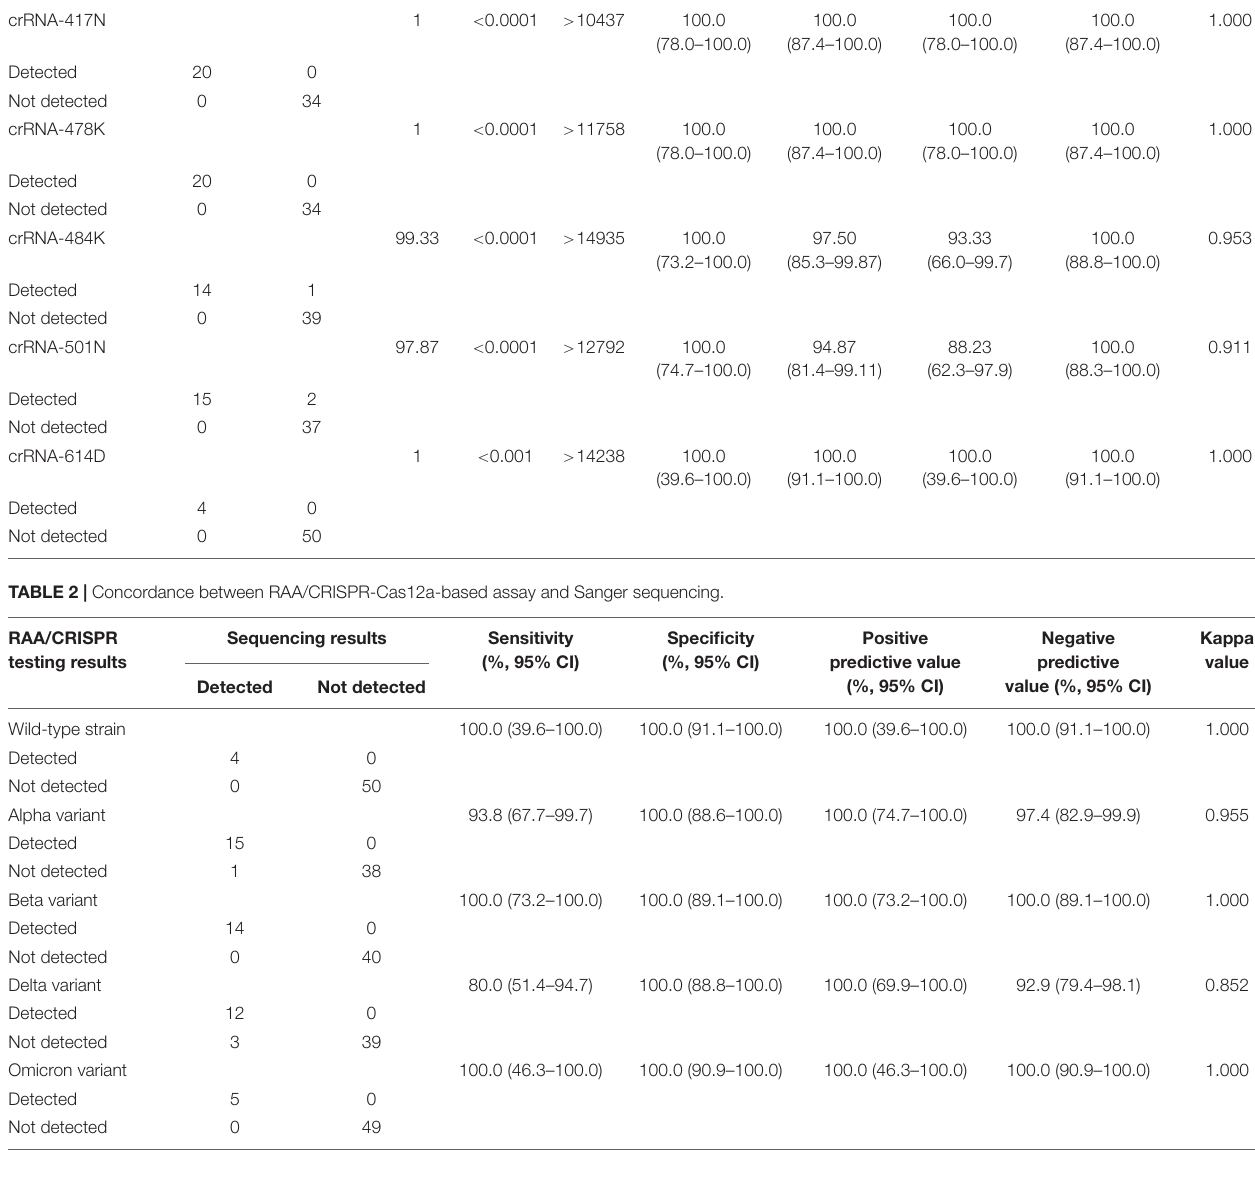
TABLE 1 | Performance of allele-specific crRNAs in RAA/CRISPR-Cas12a-mediated assay compared with Sanger sequencing. RAA/CRISPR testing results